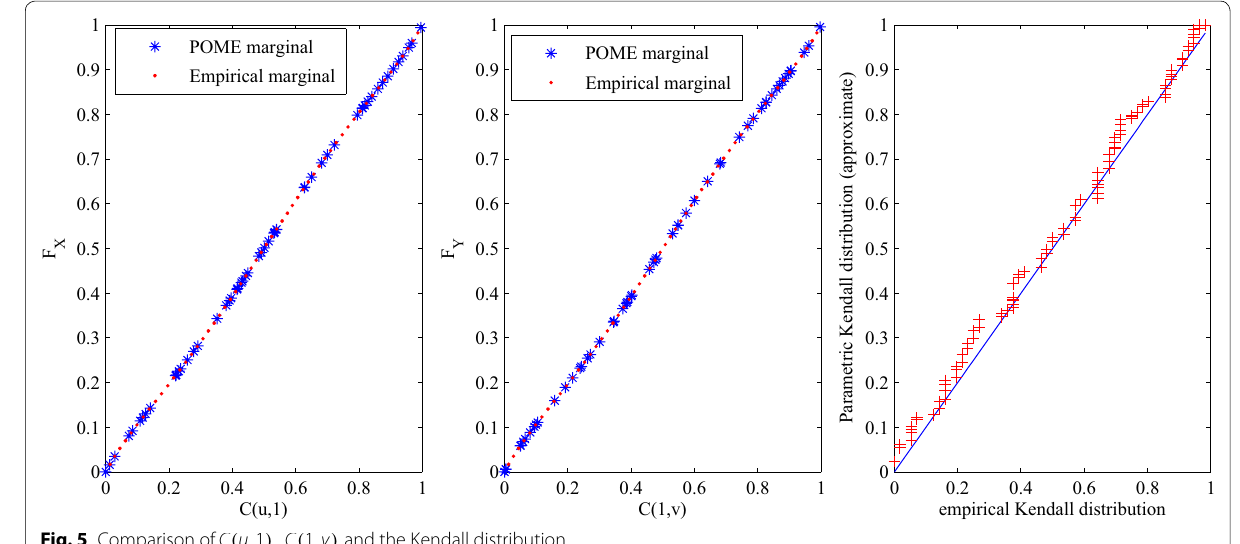
Fig. 5 Comparison of C ( u ,1 ) , C ( 1, v ) , and the Kendall distribution